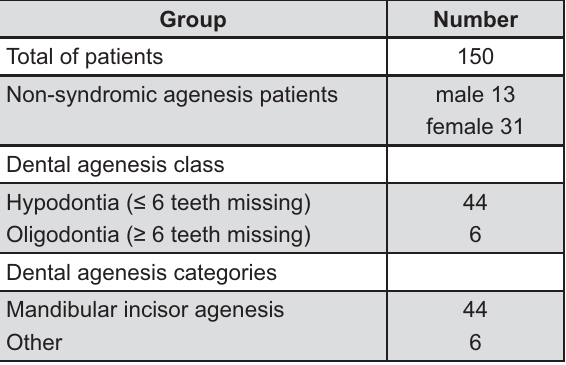
Figure 1- Number of individuals with dental agenesis